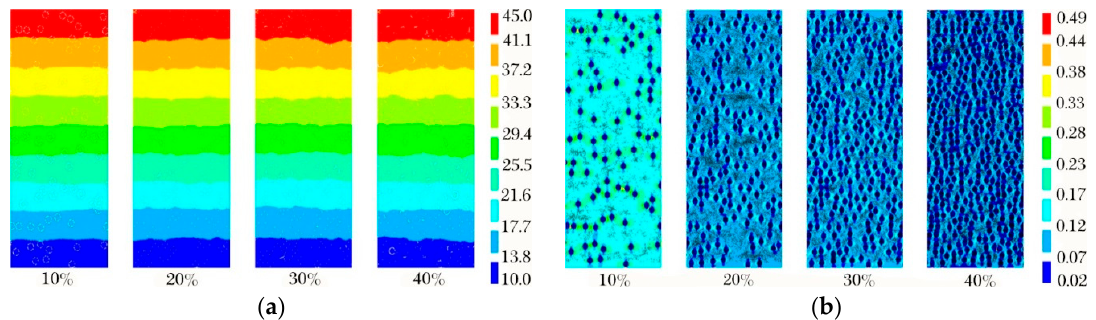
Figure 9. ( a ) Temperature nephogram; ( b ) Thermal vector nephogram.